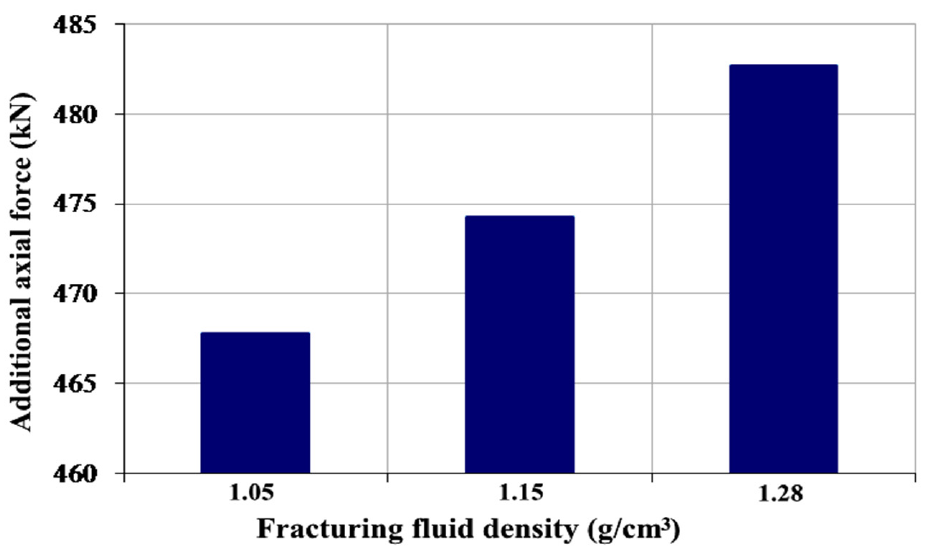
Figure 3. Additional axial force of casing under different fracturing fluid densities.